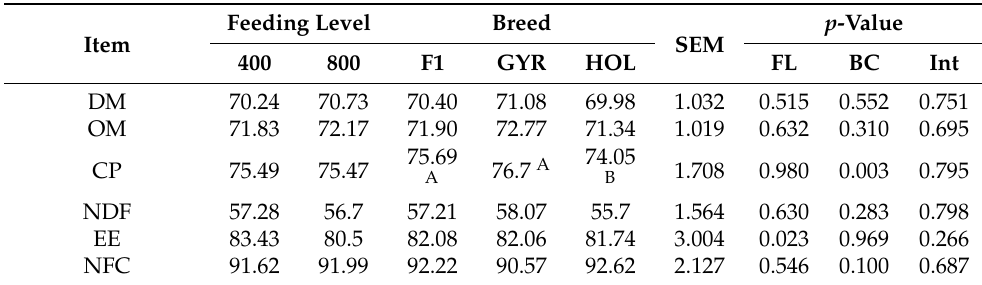
Table 3. Apparent total tract digestibility of dietary nutrients (%) of dairy heifers of three breed compositions (BCs) at two feeding levels. Feeding Item